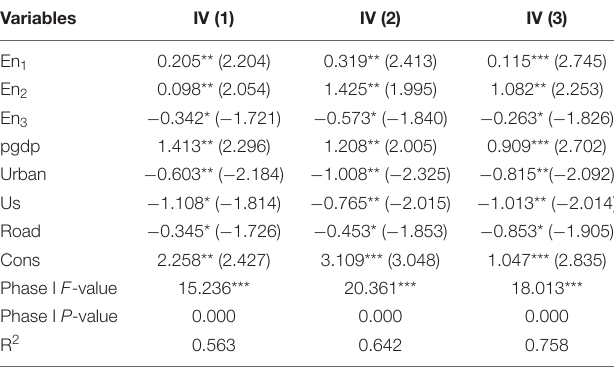
TABLE 3 | Regression results for the instrumental variables